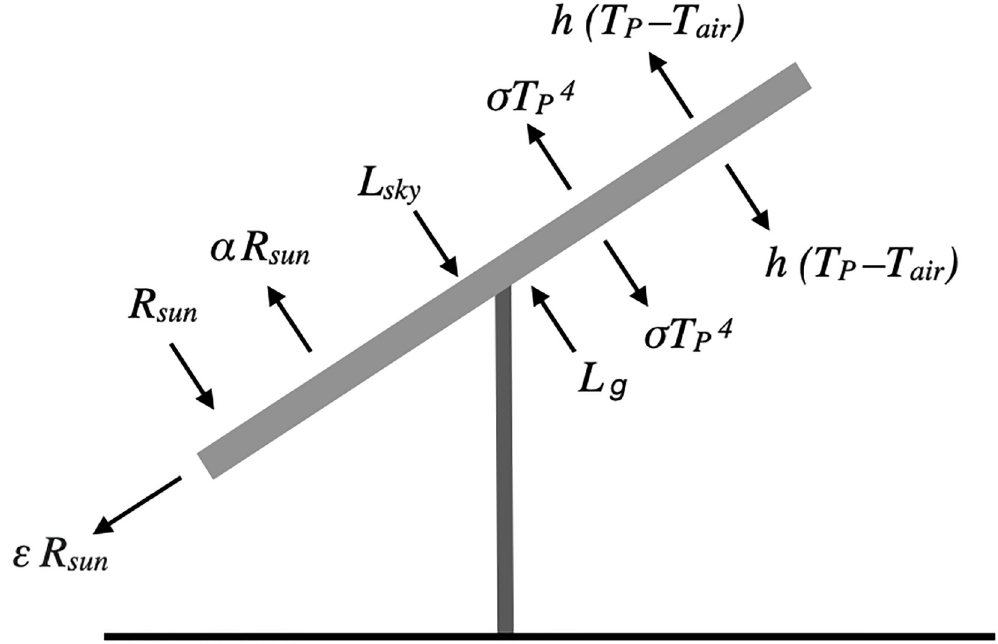
Fig 9. Energy pathways for a panel, corresponding to Eq 14 (Adeh